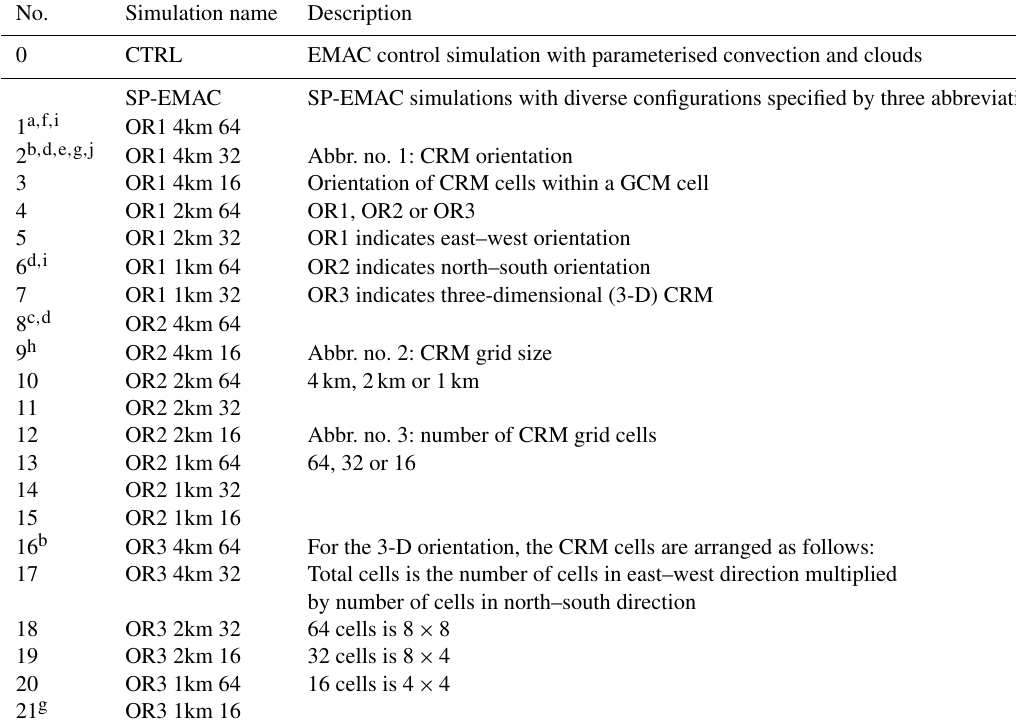
Table 1. Overview of sensitivity simulations. No. Simulation name Description 0 CTRL EMAC control simulation with parameterised convection and clouds SP-EMAC SP-EMAC simulations with diverse configurations specified by three